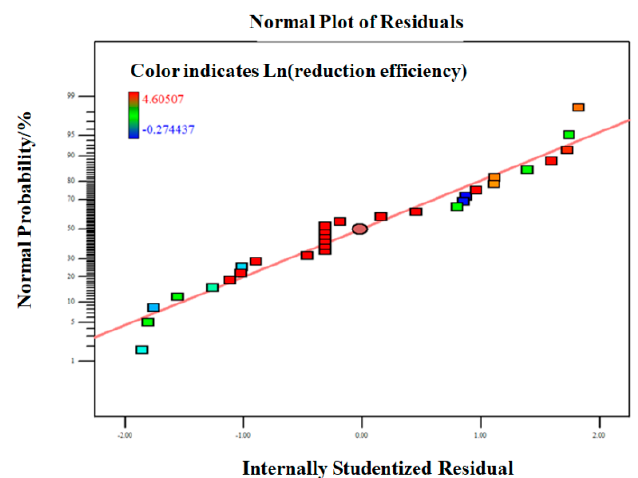
Figure 5. Normal probabilities of the residuals.